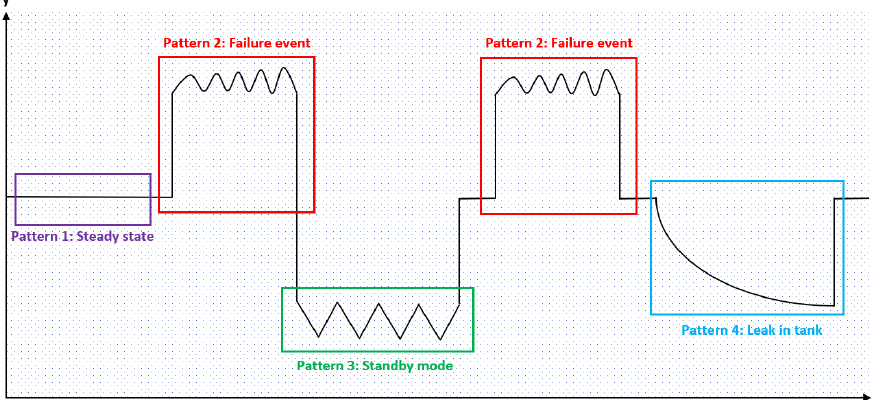
Figure 1. Abstract schematic to illustrate di ff erent patterns in a time series.